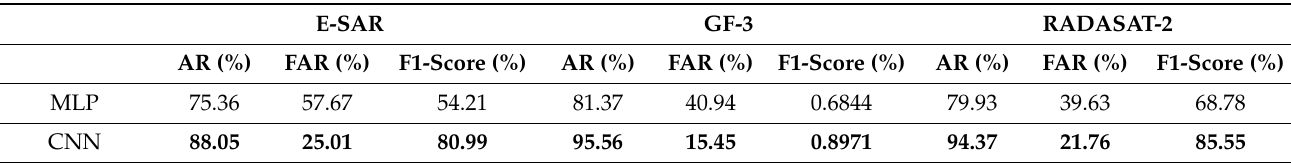
Table 5. Building extraction accuracy table using the MLP and CNN methods.